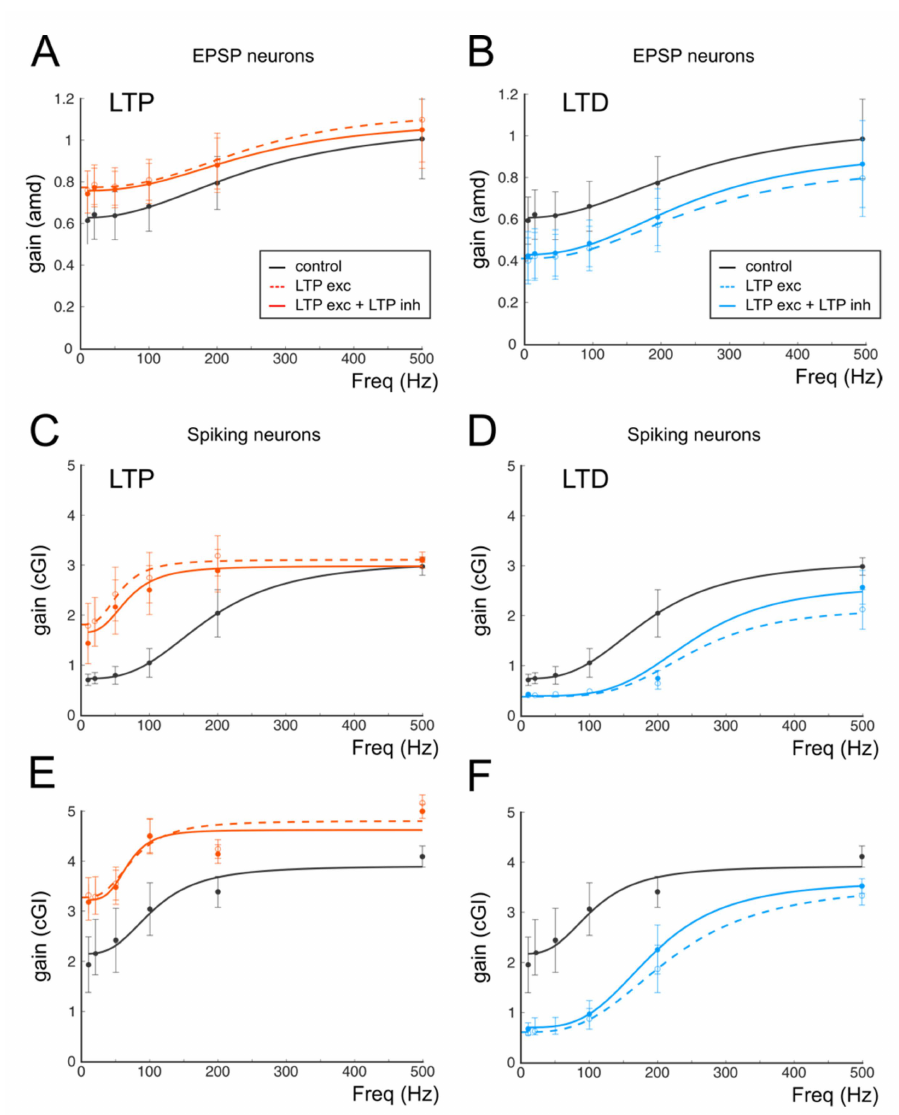
Figure 7. The effect of GABAergic plasticity on gain curves. ( A ) Gain curves of a cell receiving a combination of one mf and three GoCs and responding with EPSPs. Black trace (control); red dashed line (excitatory LTP); continuous red line (excitatory and inhibitory LTP). ( B ) In the same cell